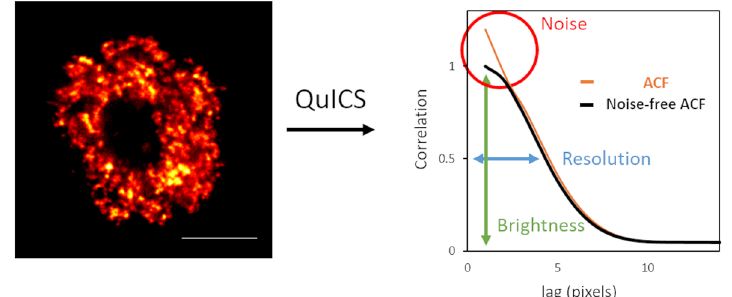
Figure 1. Autocorrelation function (ACF) as a source of information about image quality. (left) Representative image of U937-PR9 cell upon staining of DNA replication foci through incorporation of EdU labeled with Alexa azide 488 (Click reaction). Scale bar represents 3 µm. (right) Schematic representation of the application of the QuICS algorithm to an image of a nuclear process (DNA replication sites). The algorithm calculates a radial autocorrelation function (ACF, orange line) and performs a Gaussian fit of the estimated noise-free ACF (black line). The three parameters that are extracted are: the Resolution (in blue), calculated from the width of the noise-free ACF, the Brightness (in green), calculated from the amplitude of the noise-free ACF, and the Noise (in red), calculated from the difference in amplitude between the ACF and the noise-free